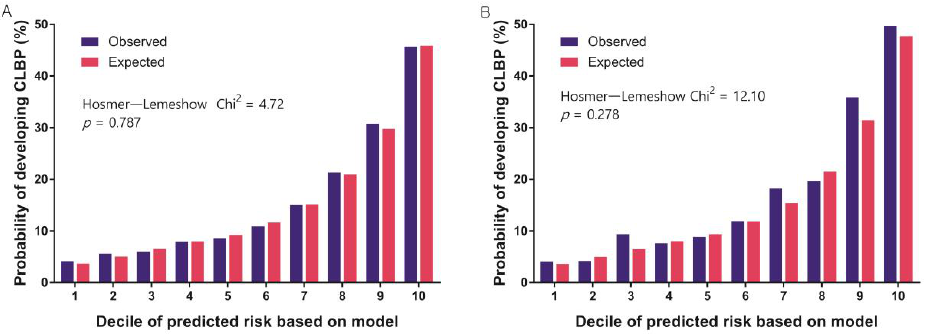
Figure 3. Calibration plots in the ( A ) development and ( B ) validation datasets.